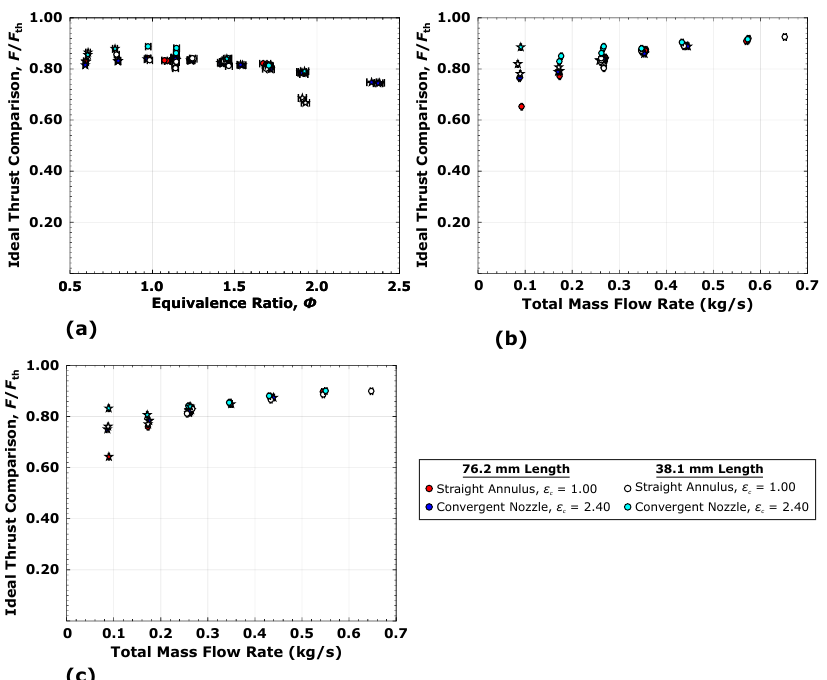
Figure 17. Ideal thrust comparison for the ( a ) equivalence ratio flow conditions at ˙ m tot = 0.272 kg/s, as well as the mass flow rate conditions for ( b ) φ = 1.15 and ( c ) φ = 1.5. Depending on the flow condition and convergent nozzle geometry, the engine operates in either a corotating ( • ) or counter- propagating mode ( (cid:63)